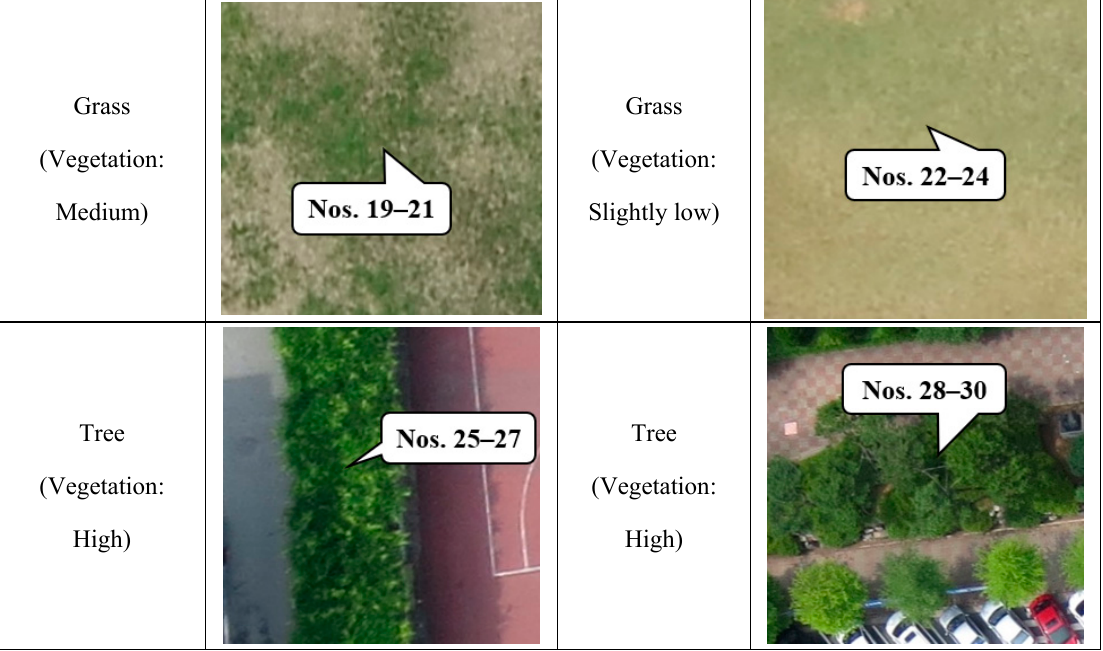
Figure 7. Examples of various types of land cover.